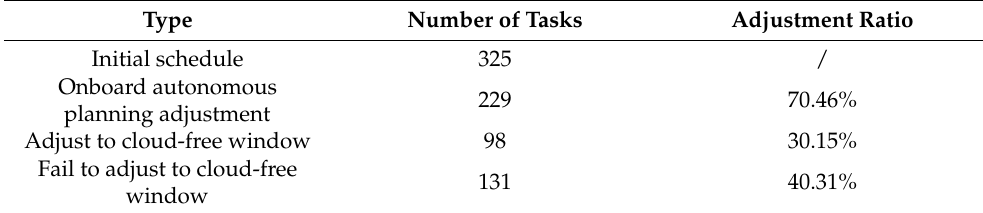
Table 4. Adjustments of the initial schedule by onboard autonomous planning.